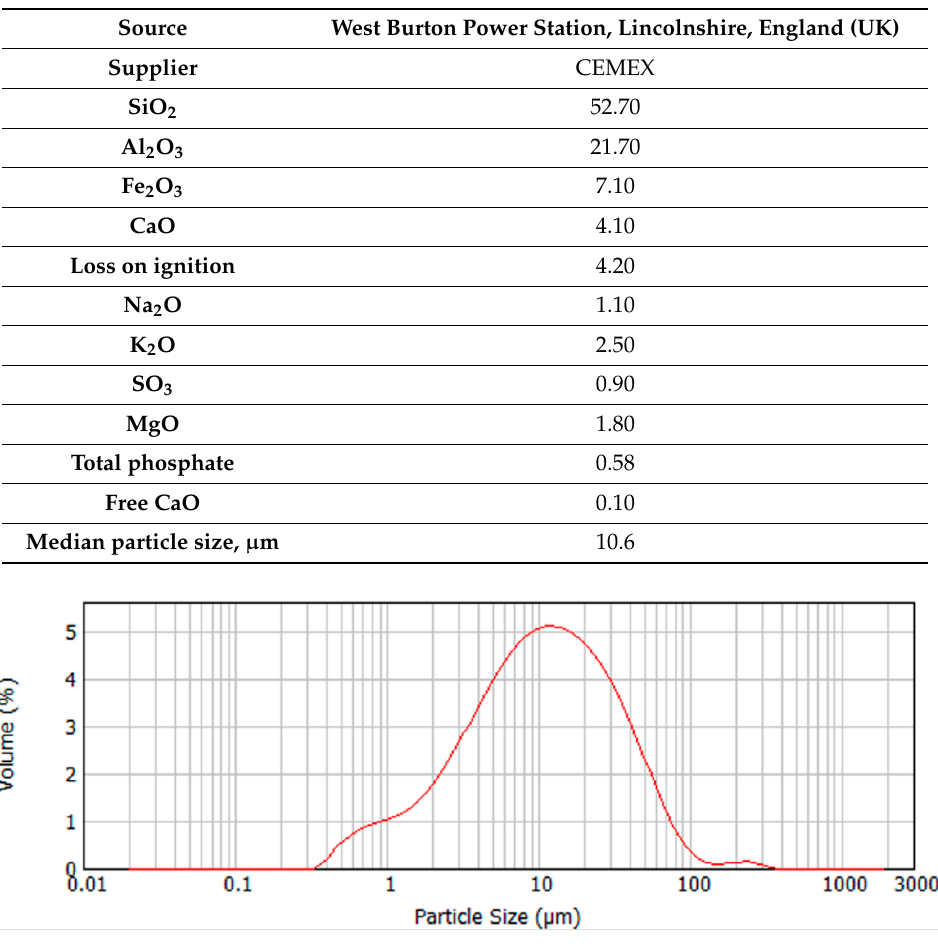
Table 1. Composition and properties of the fly ash used in this work. Source